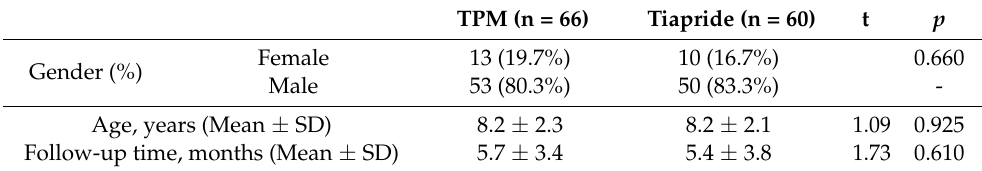
Table 1. TPM and tiapride group demographic and clinical characteristics.